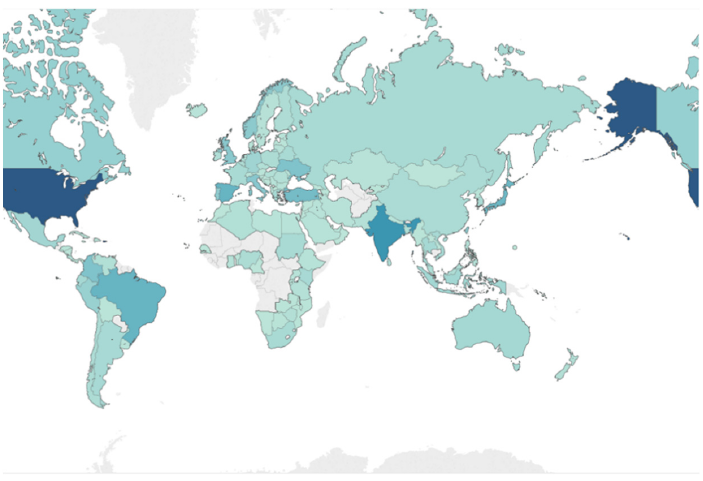
Figure 3. Countries that use DSpace (based on DSpace registry).